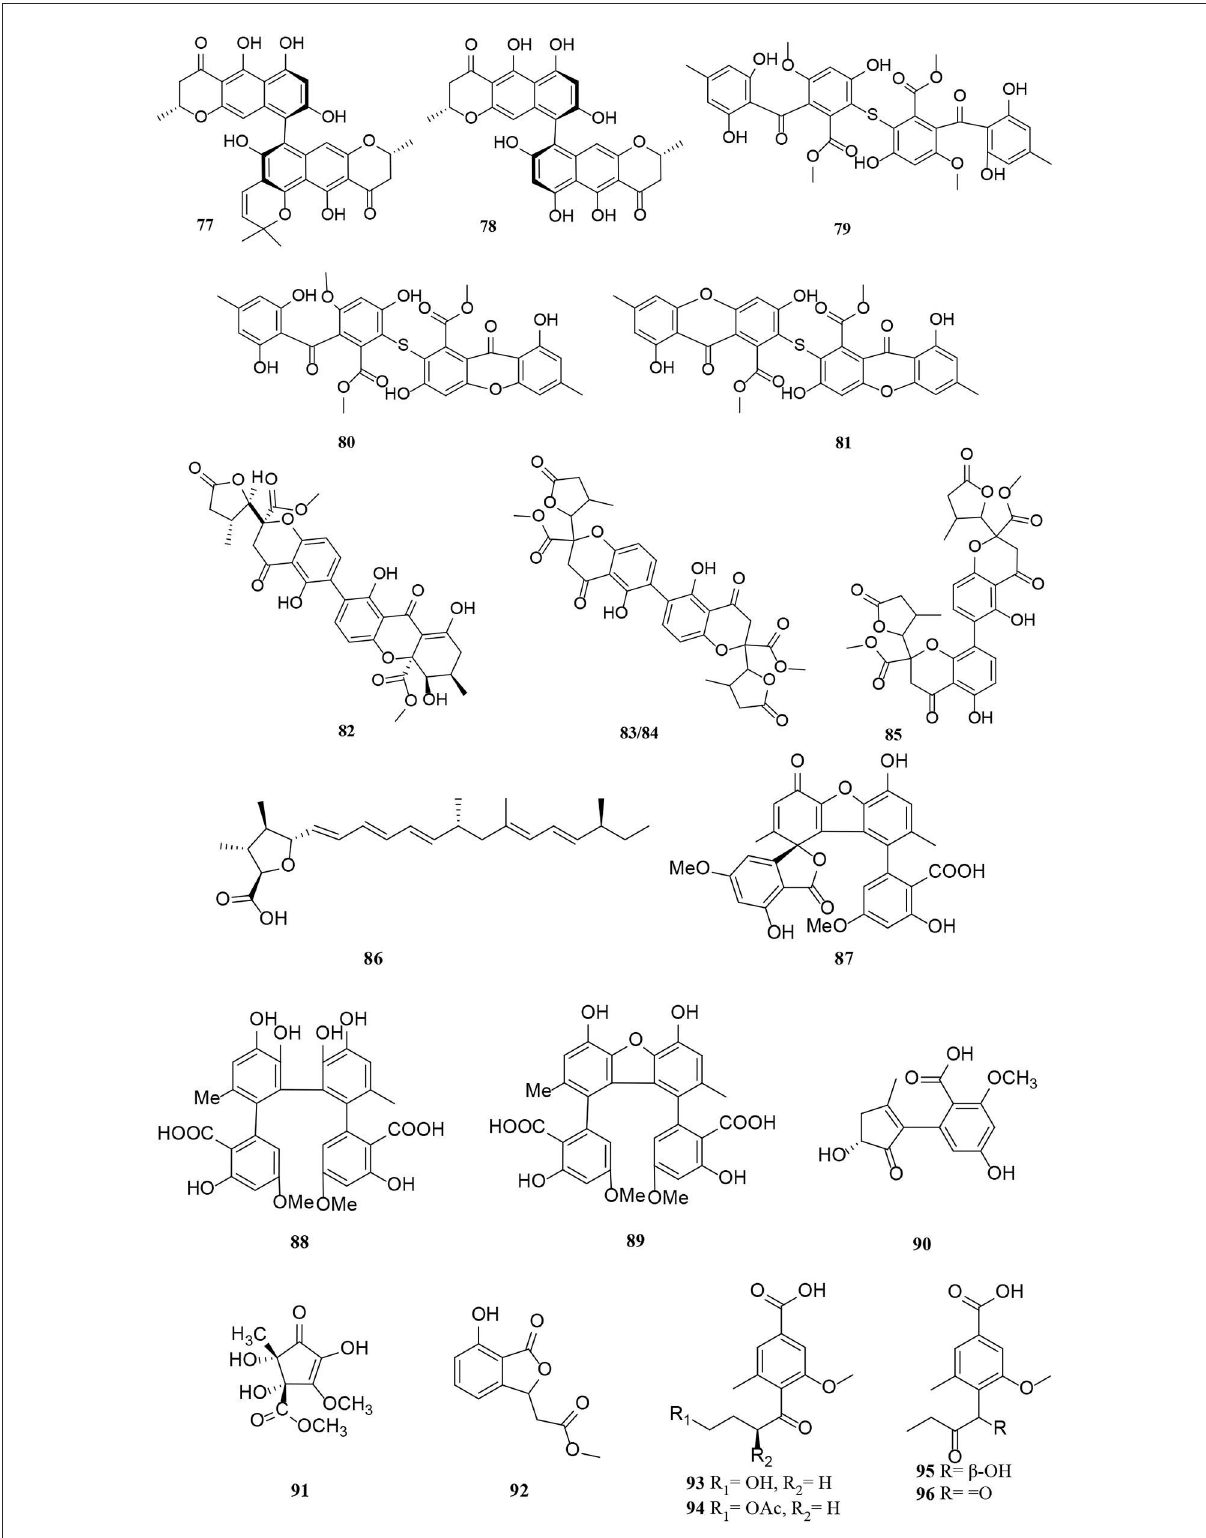
FIGURE5 Polyketide derivatives ( 77 – 96 ) from Alternaria